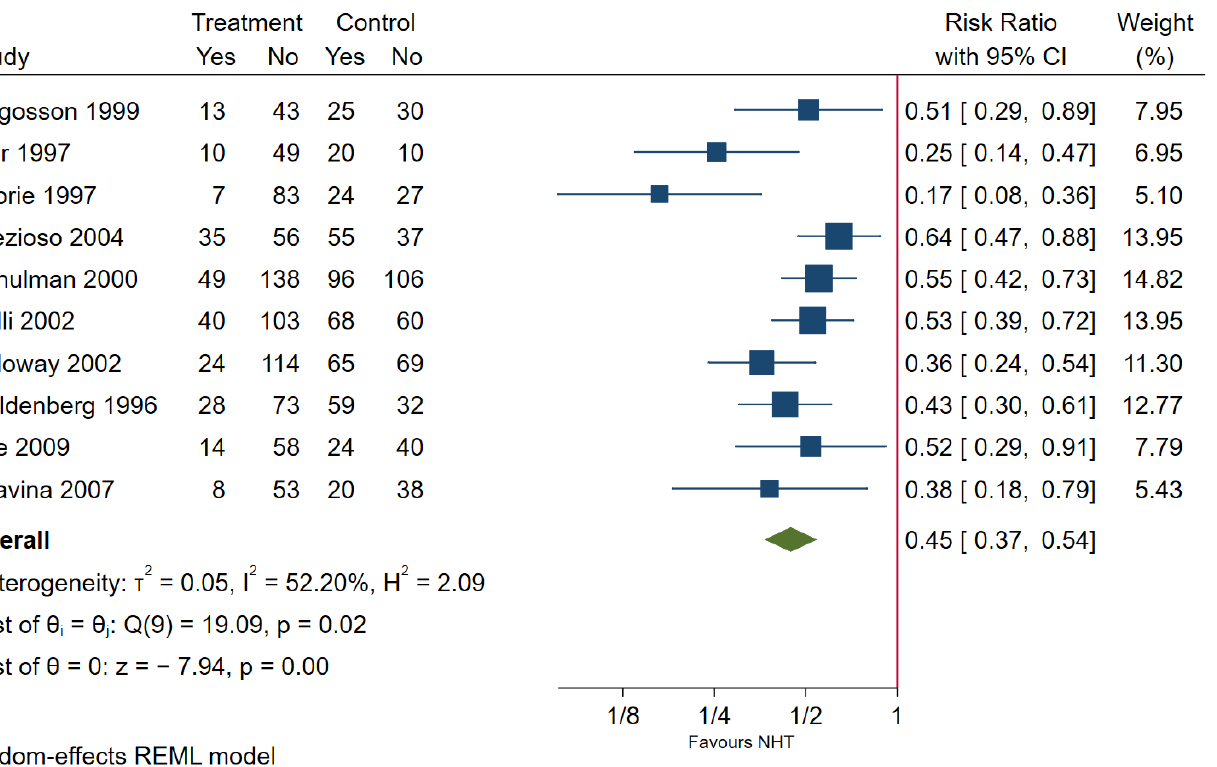
Figure 4. Positive surgical margin in patients undergoing 3 months NHT followed by RP or RP only.